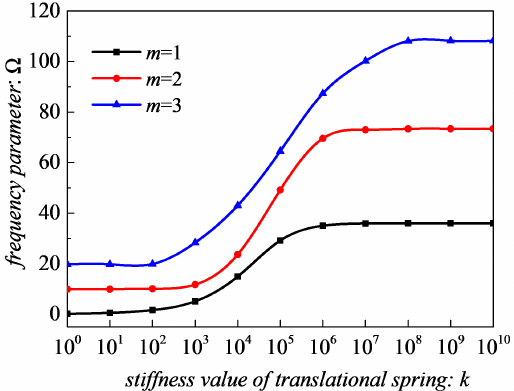
Table 2: Stiffness value of springs on each edge for different bound- ary